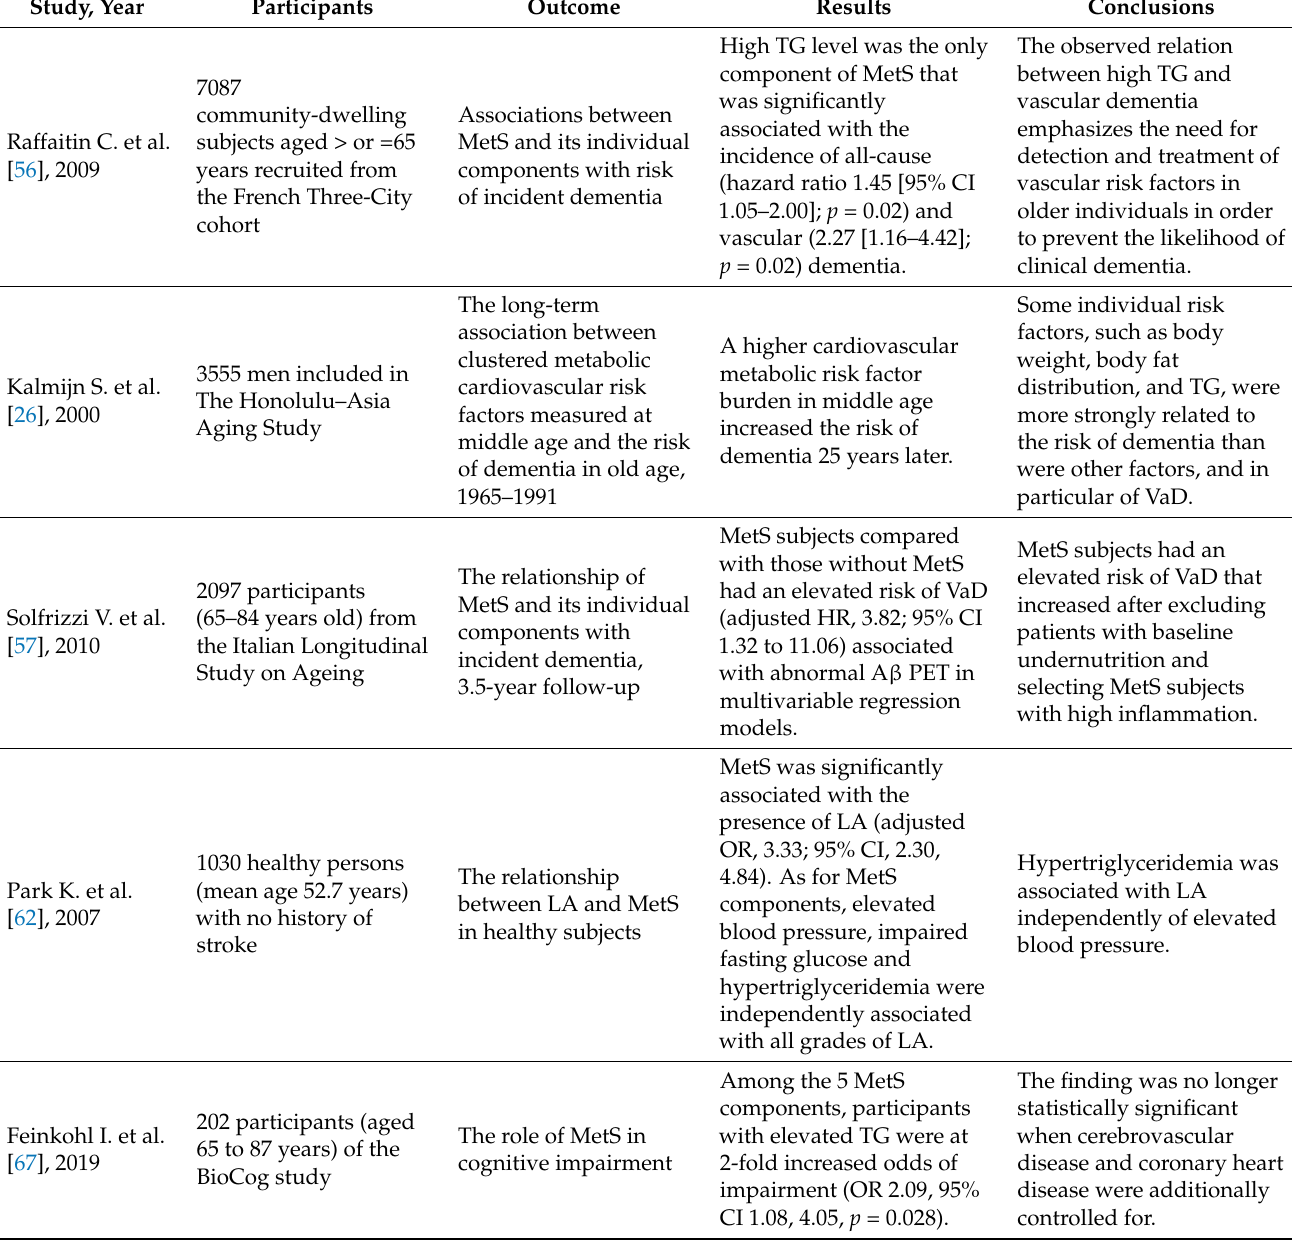
Table 3. Characteristics of the clinical studies concerning triglycerides and vascular cognitive